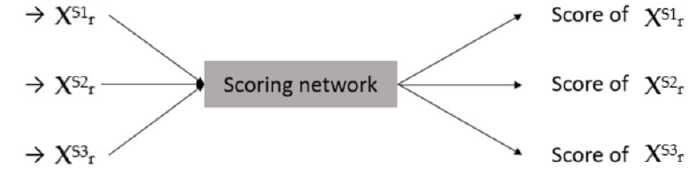
Figure 6. Scoring network. Figure 6. Scoring